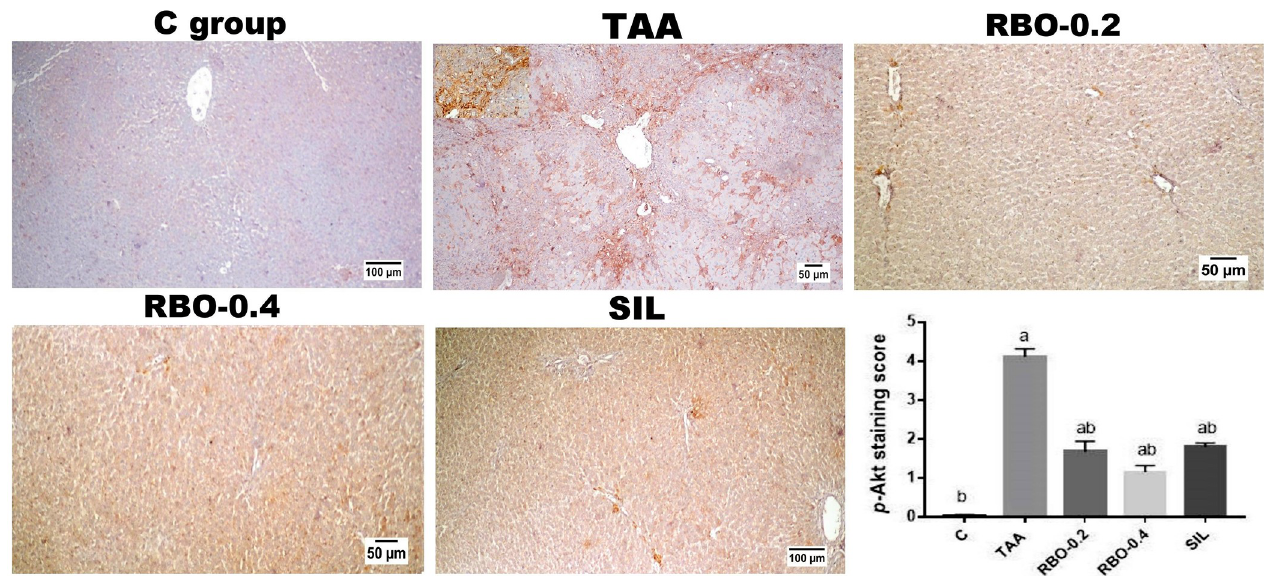
Fig 7. Immunohistochemical analysis of p-Akt expression in various experimental groups showing negative expression in control group, marked increased expression along the extended fibrous bands (upper insert) in TAA group, significant dose-related decreased expression following the decreased fibroplasia in RBO treated groups, and limited expression in SIL treated group. The quantitative image analysis of the area percent of the positive brown colour presented as intensity scores. All data are presented as Mean ± SEM, (n = 6). a P � 0.05 was assumed to denote statistical significance compared to the negative control, b P � 0.05 was assumed to denote statistical significance compared to TAA group. C: control; TAA: Thioacetamide; RBO: Rice bran oil.